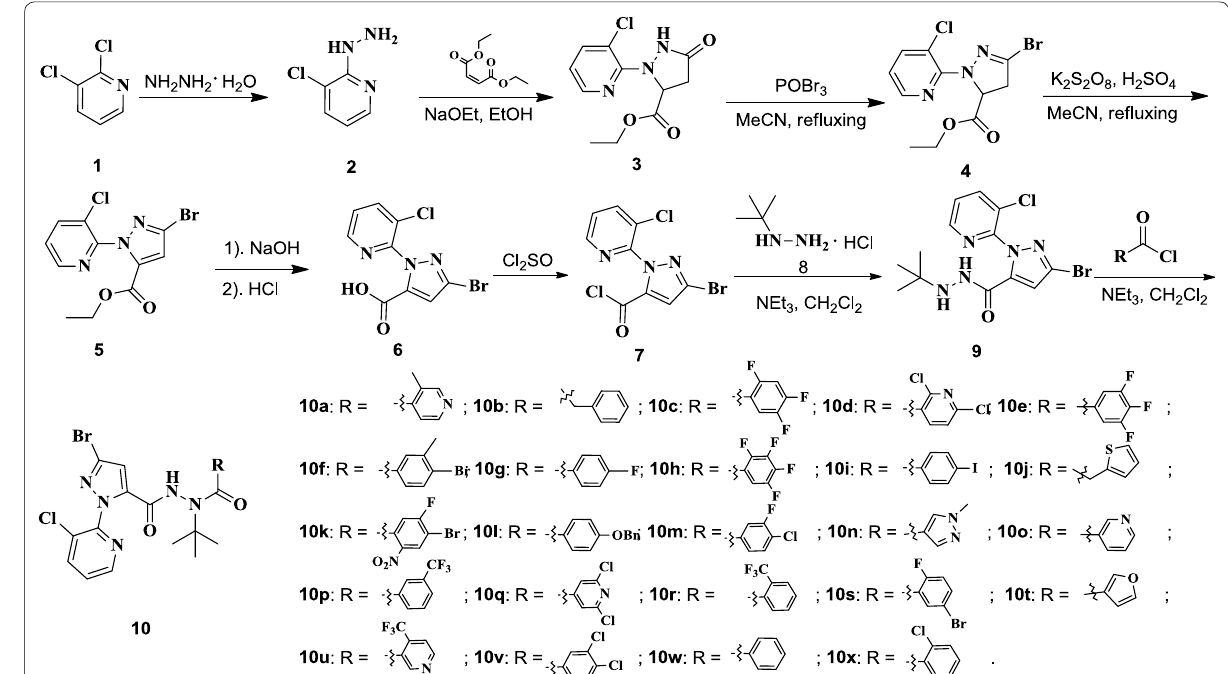
Fig. 2 The design of title compounds